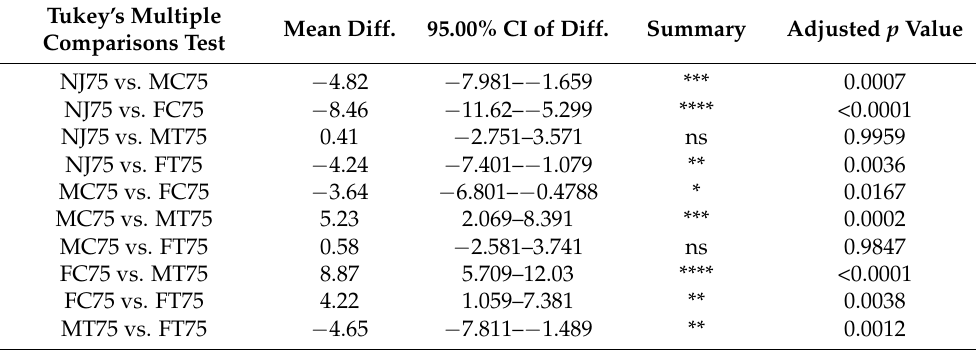
Table 6. Results of Tukey Test for individual batches, in which **** indicates the level-4 significance, *** indicates a level-3 significance, ** indicates a level-2 significance, * indicates a level-2 significance, and ns indicates no